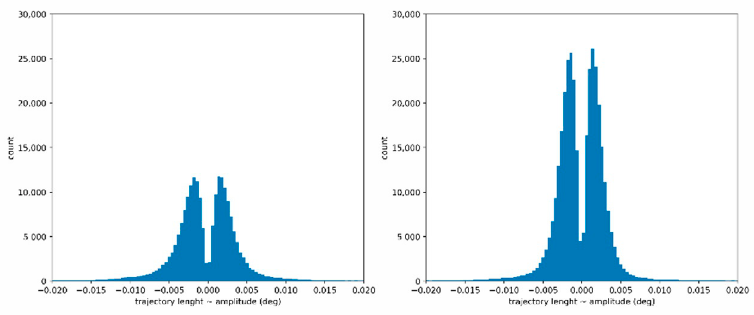
Figure 3. Combined painting—Histogram of the amplitude segments. The left histogram corresponds to the non ‐ dyslexic population, while the right histo ‐ gram corresponds to the dyslexic population. The two histograms were computed using 100 bins, showing a statistical distribution with two main modes that correspond to the peak of micro convergence and micro divergence amplitude segments.